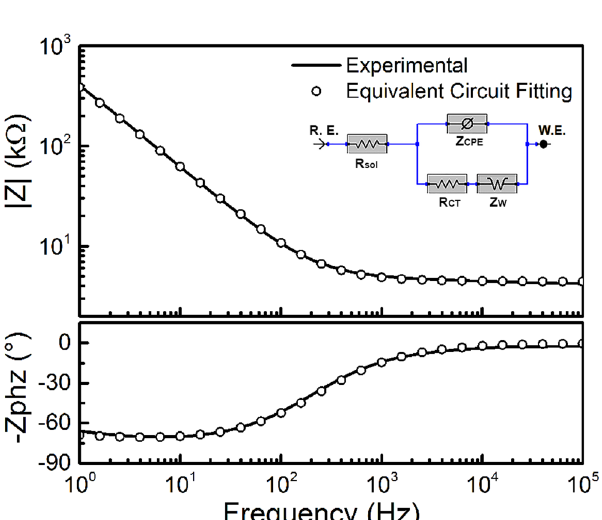
Table 1. Summary of key parameters in voltage transients for GC and Pt microelectrodes (continuous data in Fig. 4). E